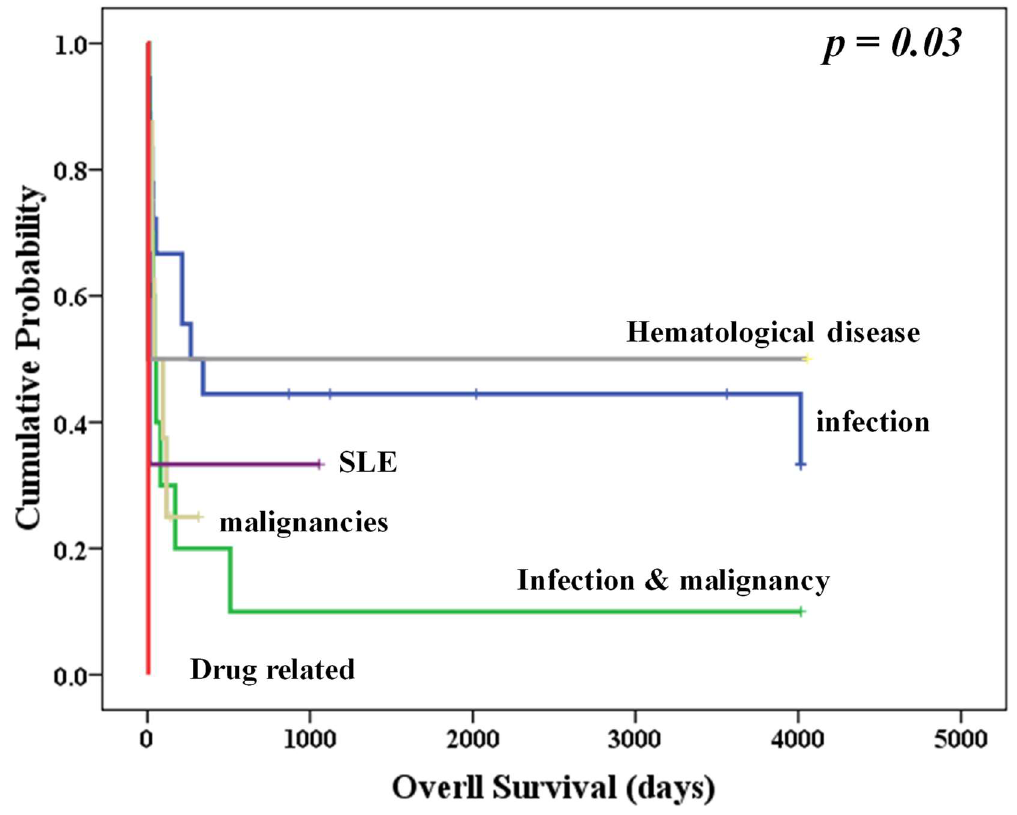
Figure 1. Overall survival of patients with different etiologies of secondary HLH. Table 2. Mortality and survival rates in patients with different etiologies of HLH.